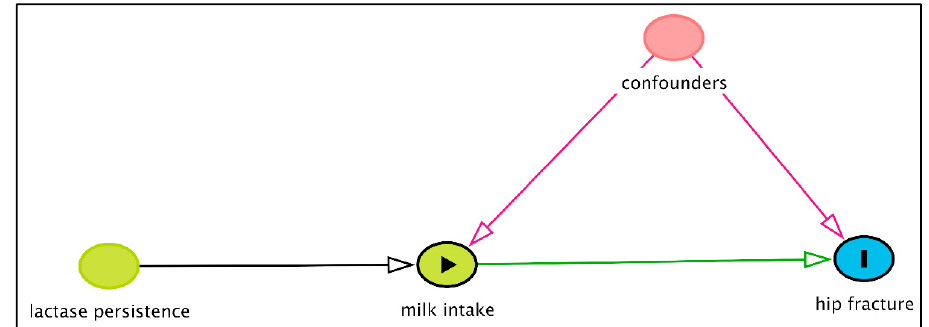
Figure 3. Causal diagram illustrating the underlying assumptions for a Mendelian randomisation study of the causal effect of milk intake on hip fractures using the MCM6 C/T single nucleotide polymorphism (SNP) (rs4988235), here denoted as “lactase persistence”, as an instrumental variable for the milk intake. The causal diagram was created using DAGitty.net [124].